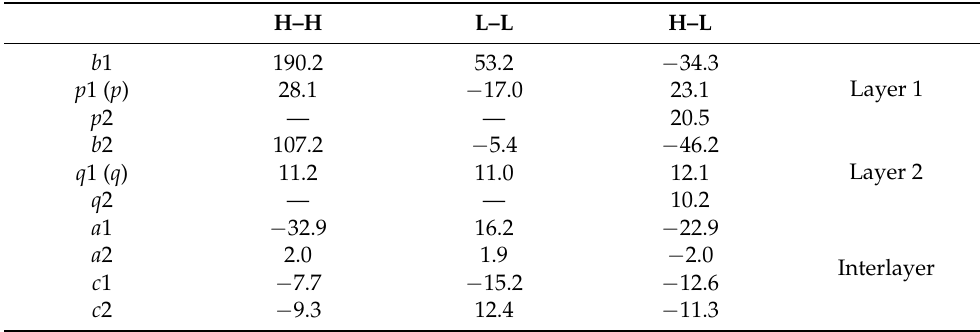
Table 3. HOMO–HOMO (H–H), LUMO–LUMO (L–L), and HOMO–LUMO (H–L) transfer integrals (meV) at 7.8 GPa (Structure B).